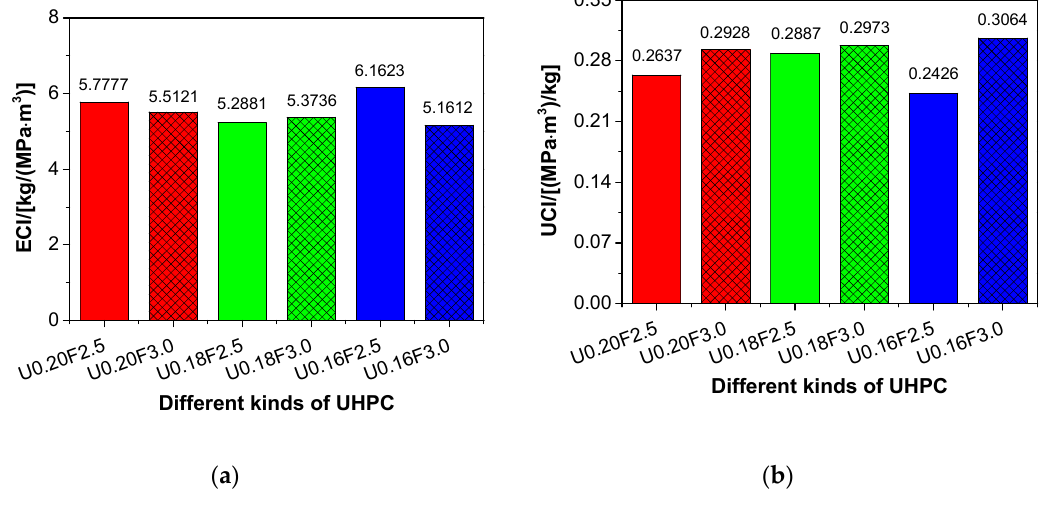
Figure 9. The environmental assessment of UHPC: ( a ) ECI and ( b ) UCI.